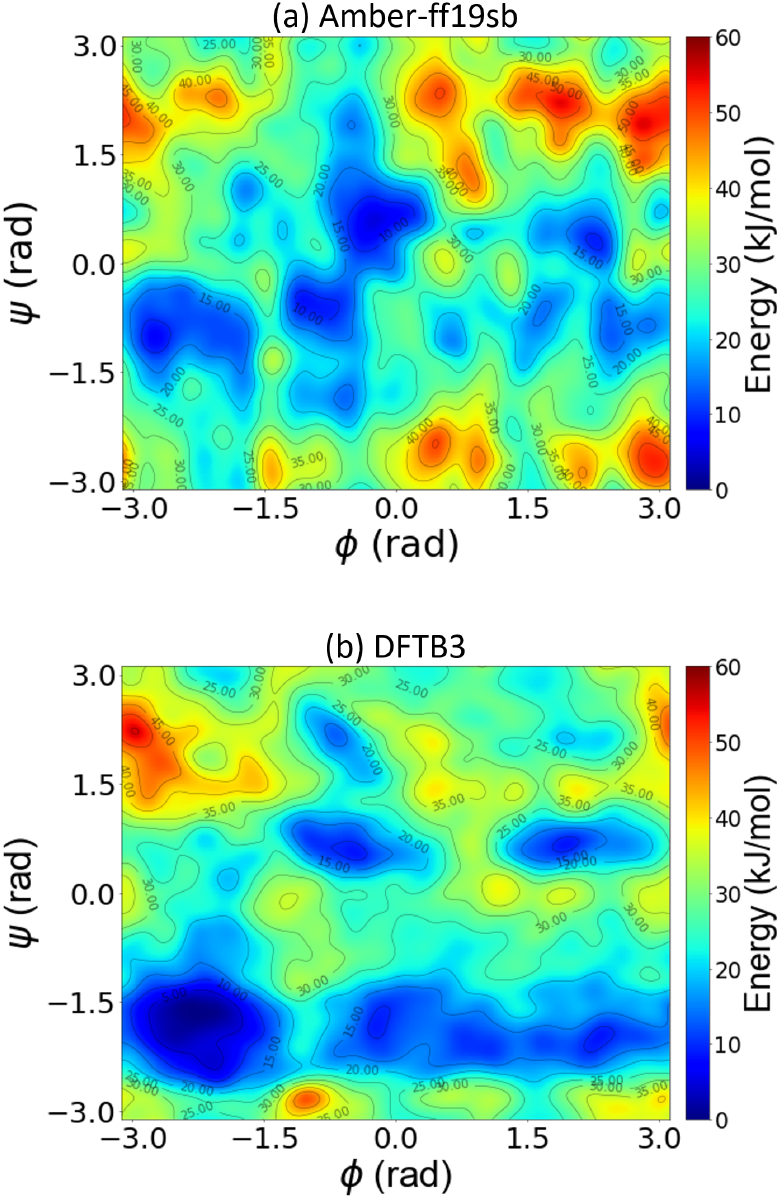
Figure 6. Two-dimensional potential energy surface of remdesivir as a function of the backbone dihedral angles, φ and ψ , obtained from well-tempered metadynamics simulations using ( a ) classical MD from the Amber99sb force field and ( b ) SCC-DFTB3